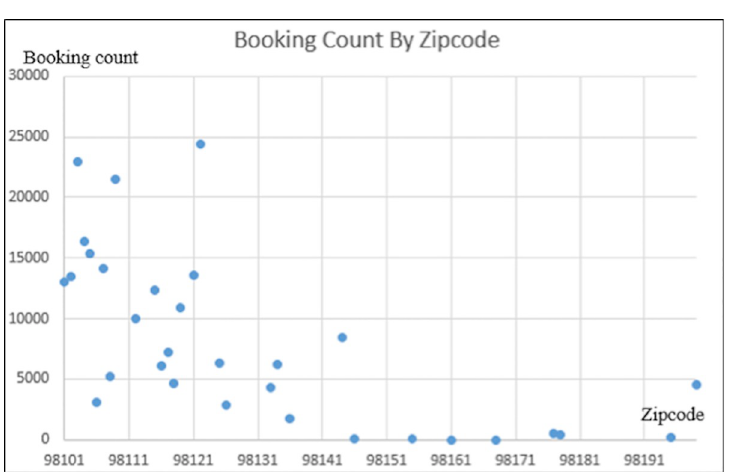
Fig 5. Number of bookings per zip code. � The zip codes are not all listed in the graph because of space limitation. � The zip codes are not continuous, but are discrete values.